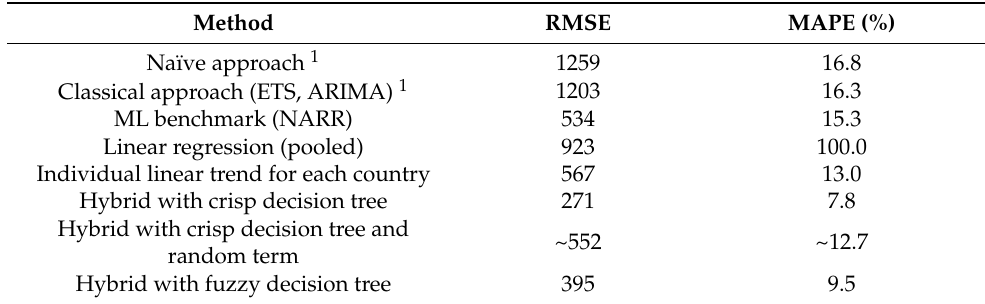
Table 6. Comparison of errors for individual benchmarking approaches for all 79 analyzed